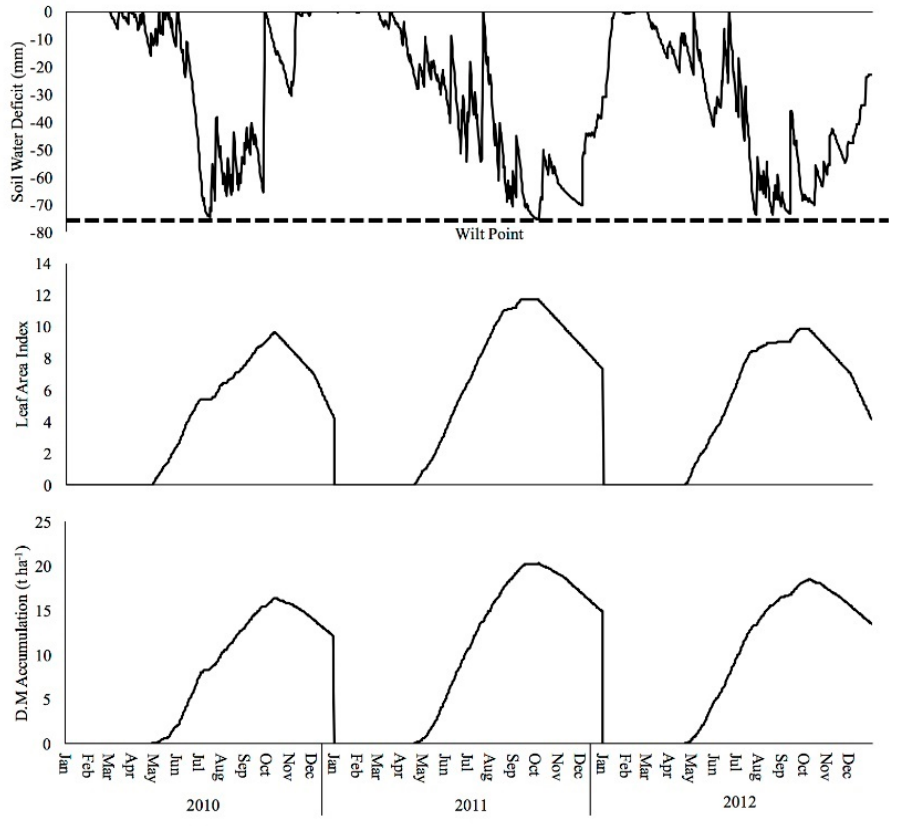
Figure 4. Modelled time series of: soil water deficit (SWD) (upper panel), leaf area index (middle panel) and dry matter yields in Mg ha -1 (lower panel) during the growing seasons 2010, 2011 and 2012 plotted against journal day. The wilt point is shown on the SWD curve to indicate timing of drought stress.